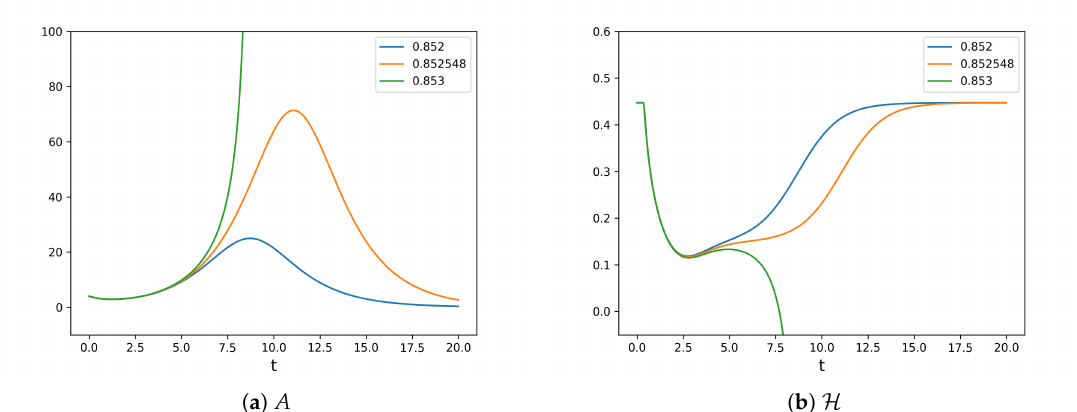
Figure 14. The metric function A and the expansion rate H with λ = 0.6 along u = v equiv. z = 0 for multiple values of a close to a 1